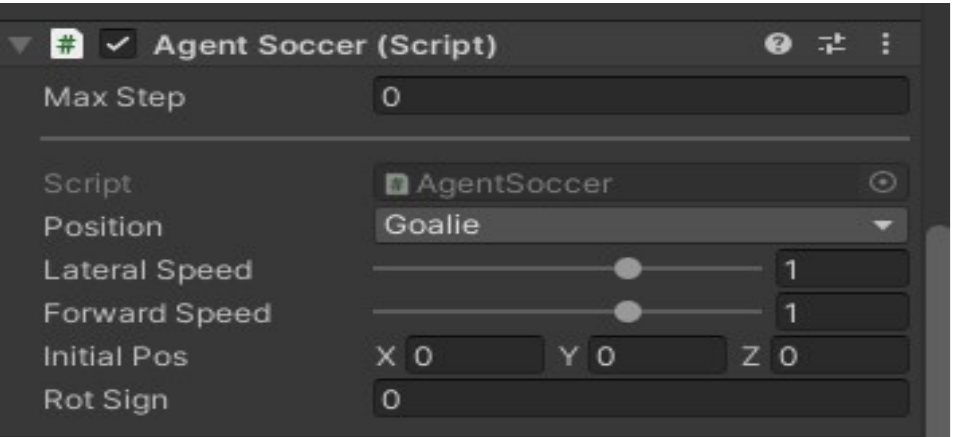
Figure 4. AI agent - player’s position—goalkeeper (goalie).